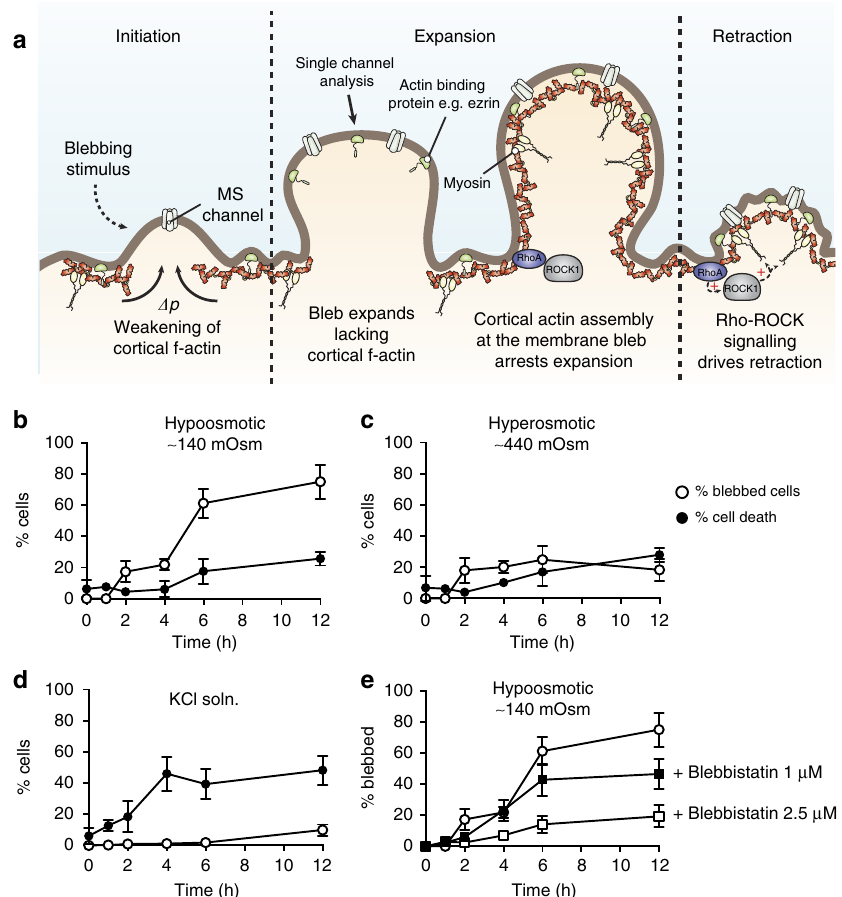
Figure 1 | Overview of membrane bleb formation and the efficiency of blebbing solutions on HEK293 cells including the effect on cell viability. ( a ) Formation of membrane blebs consists of three phases: initiation, expansion and retraction. Initiation of blebs can be instigated by a variety of stimuli, and certain cell lines continually bleb (for example, M12 cell line 68 ). The initiation phase usually involves a focal weakening or rupture of the cortical cytoskeleton and bleb expansion continues largely devoid of cortical f-actin driven by hydrostatic pressure 69 and actomyosin contractility. Once polymerization of f-actin begins at the bleb membrane, expansion is halted. In the physiological setting, Rho-ROCK signalling then drives bleb retraction again via actomyosin contractility. Illustration of the number of cells blebbing and the corresponding % cells stained with trypan blue in response to treatment with ( b ) a hypoosmotic NaGluconate solution ( B 140mOsm), ( c ) a hyperosmotic NaGluconate solution ( B 440mOsm) and ( d ) a Ca 2 þ free KCl-based solution (first described for use in myocytes 35,70 ). ( e ) Illustration of the dependence of blebbing on the activity of myosin II with almost complete abolition of bleb formation in the presence of 2.5 m M blebbistatin (data points represent mean ± s.e.m.; n ¼ 4 with each replicate including 4 250